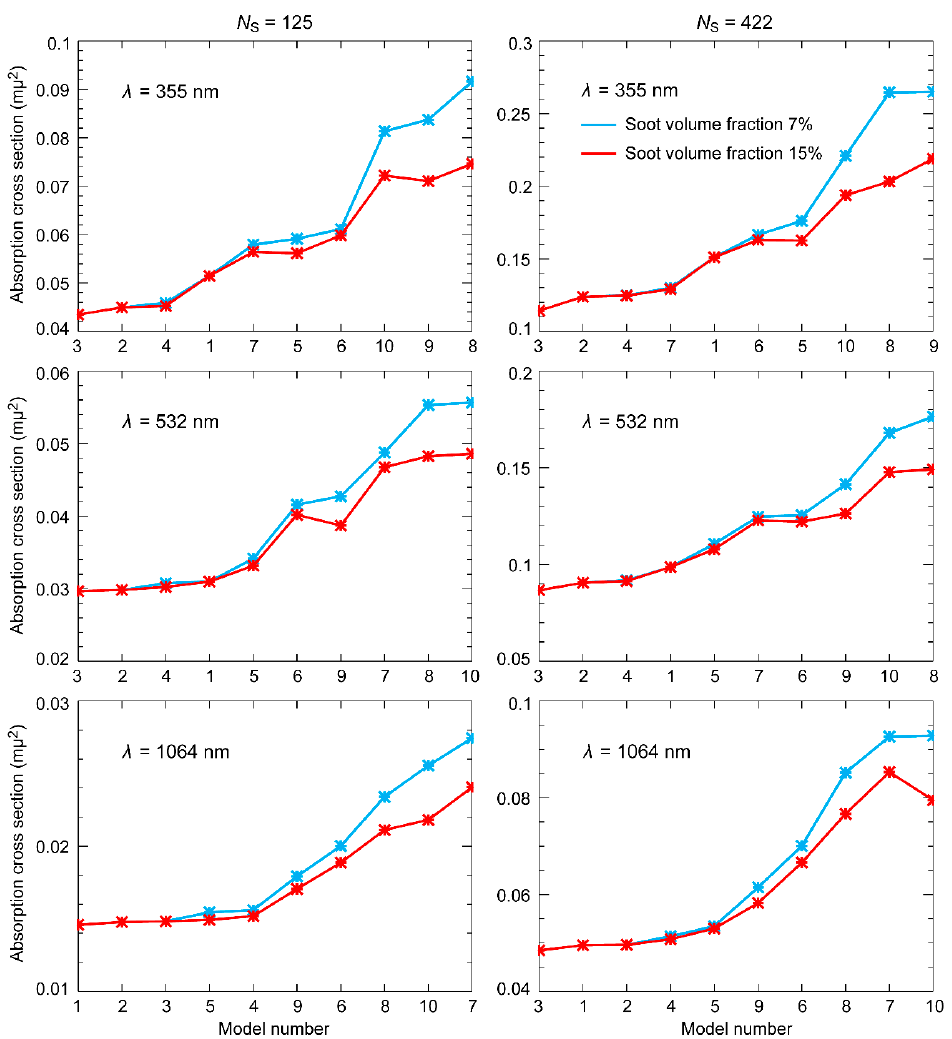
Figure 5. Polydisperse absorption cross sections (in µm 2 ) for Model 1 to 10 aerosols. The number of soot spherules is N S = 125 (left-hand panels) and 422 (right-hand panels).